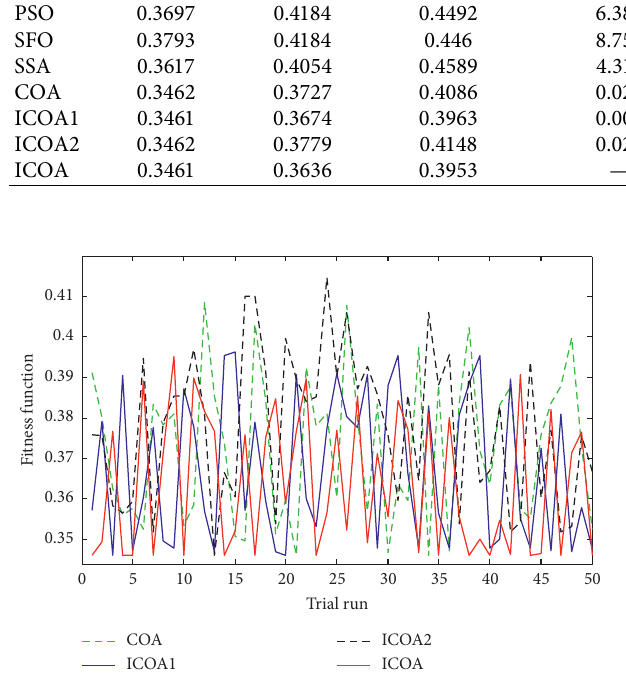
Figure 4: The fitness values of four methods in 50 trial times for the first case.